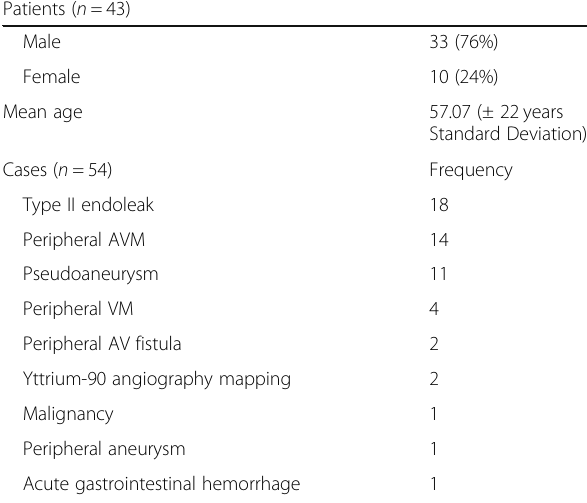
Table 1 Patient demographic and case etiologies ( n = 54)